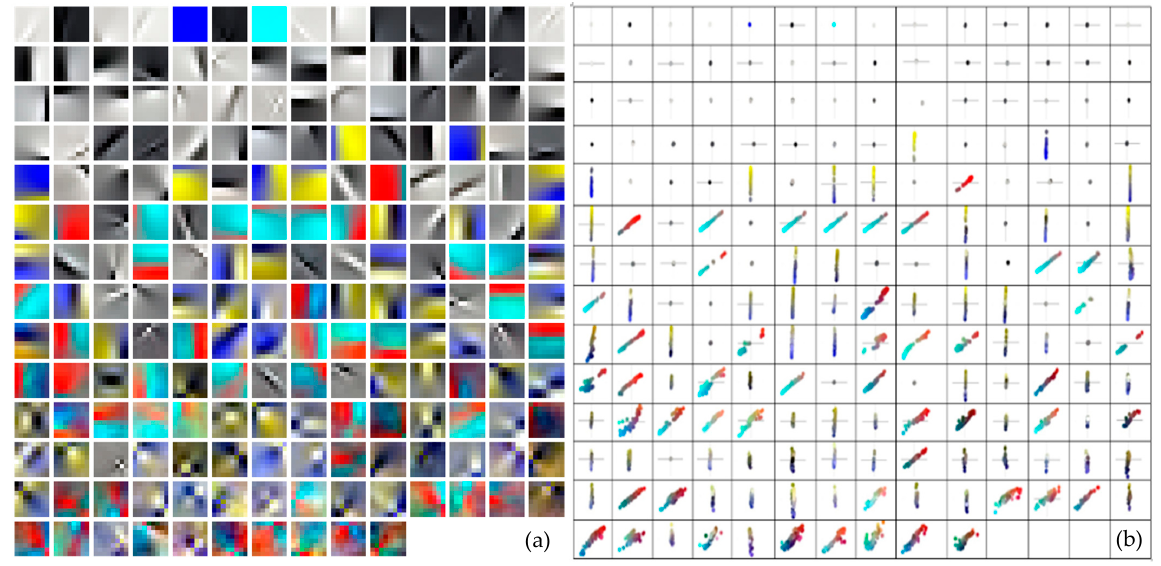
Figure 9. ( a ) Pseudo-colour representation of the spatio-chromatic structure of the activation for all 192 learned independent component analysis (ICA) basis functions. Each colour component corresponds to the R, G, and B pixel values for each 7 × 7 patch that was derived from individual basis functions. ( b ) Chromaticities of activation of each individual patch when projected onto a red-green and blue-yellow plane in the RGB colour space. The functions are in order of decreasing L 2 norm from left to right and top to bottom.